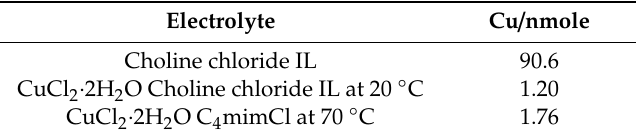
Table 1. The number of moles of copper stripped in the first oxidation process, calculated from the overall charge under the peak of the LSV using the GPES software.